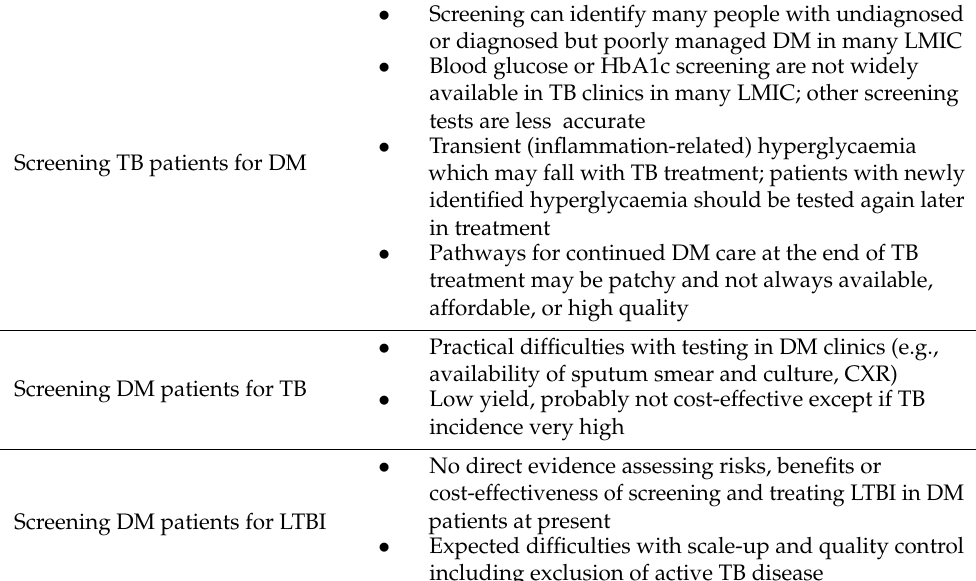
Screening TB patients for